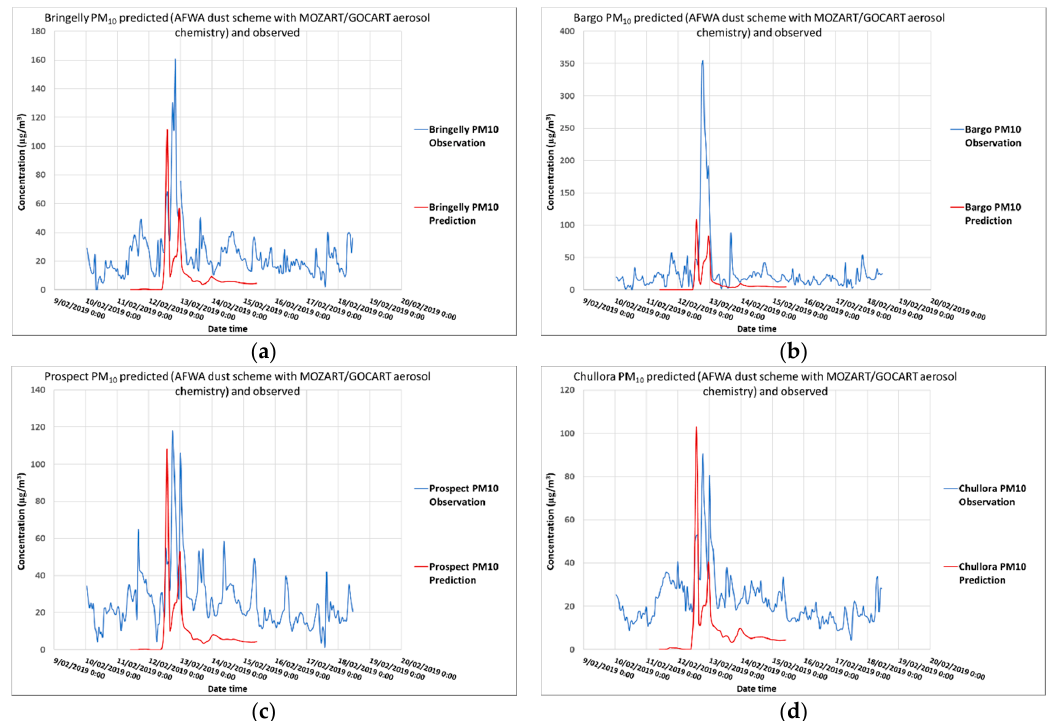
Figure 4. WRF-Chem predicted PM 10 from dust transport and observed PM 10 from air quality monitoring sites, Bringelly ( a ), Bargo ( b ), Prospect ( c ) and Chullora ( d ) in the Sydney region.